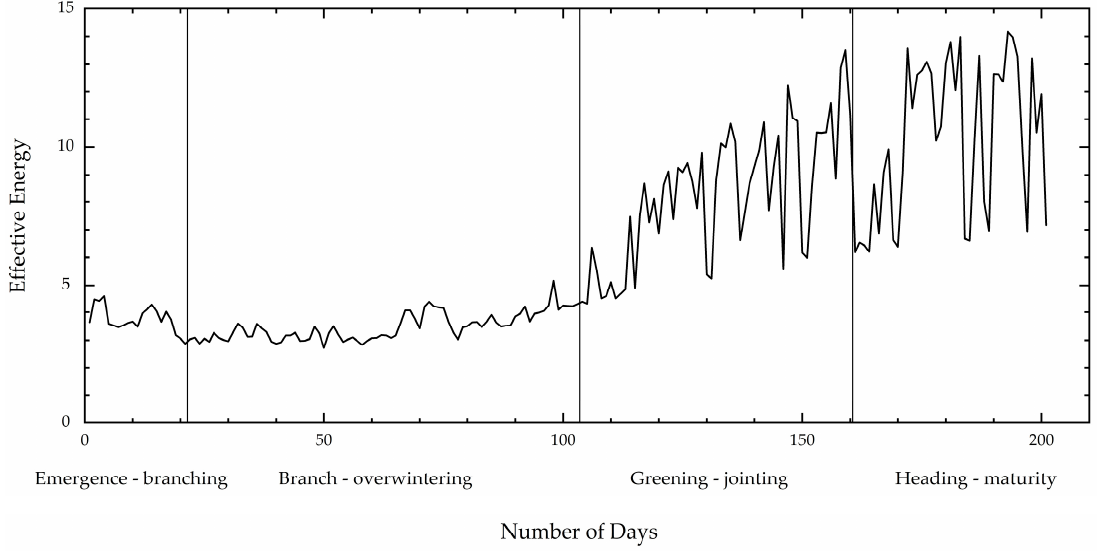
Figure 3. The variation of the e ff ective energy (R n -G).